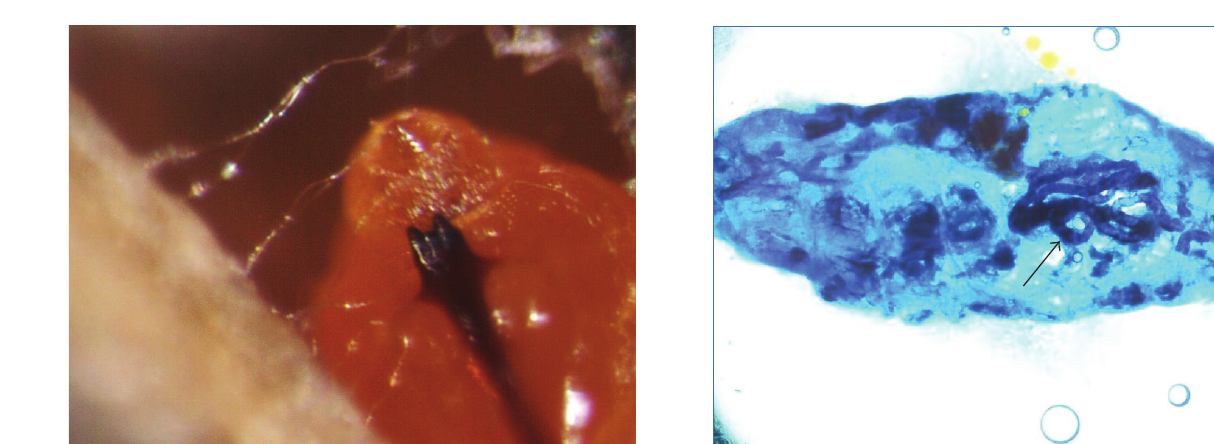
Figure 22: Longitudinal section of the late third instar shows the tubular salivary gland (arrow) associated with extraoral digestion and silk